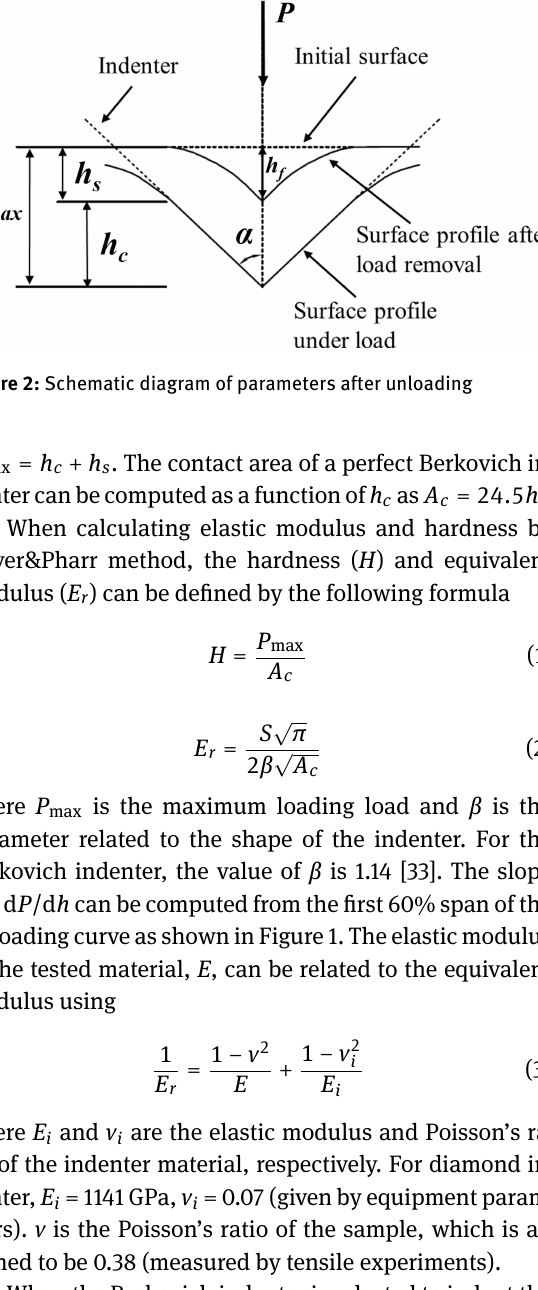
Figure 2: Schematic diagram of parameters after unloading